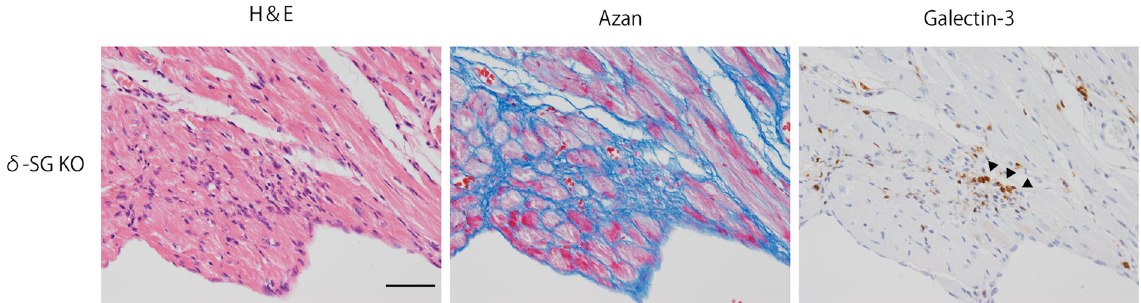
Fig 5. Immunohistochemistory of galectin-3 in the cardiac tissue of δ -SG KO mice which is the model of dilated cardiomyopathy (DCM). The infiltration of galectin-3 positive cells were shown. Arrows indicate galection-3 postitive cells. Scale bar = 50 μ m.